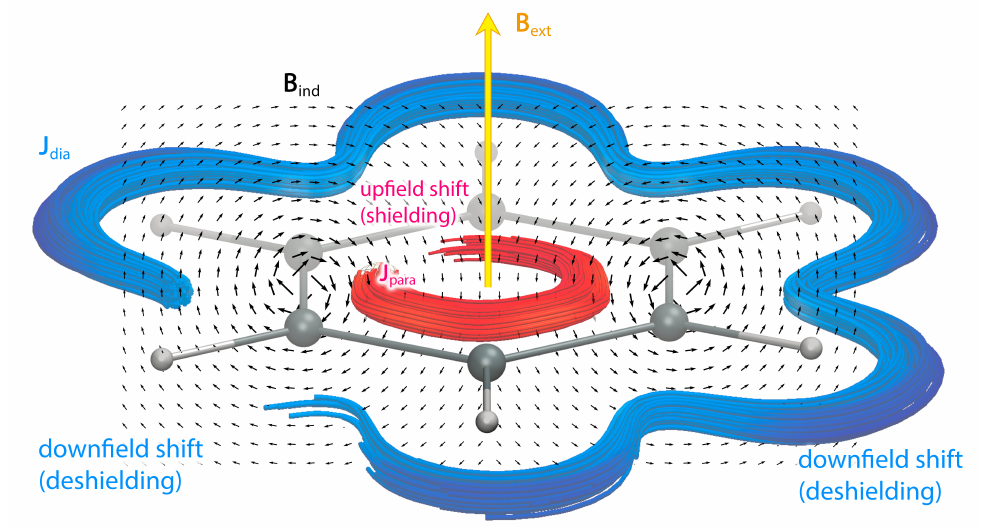
Figure 1. Illustration of the induced magnetic field (black arrows) when the aromatic benzene is exposed to an external magnetic field (yellow) perpendicular to the molecular ring. The magnetically induced current density circling in the classical direction is called diatropic (blue) and the one flowing in the opposite direction is paratropic (red). The induced magnetic field in the center of the ring points in the opposite direction relative to the applied field, while it deshields the nuclear magnetic moment of the hydrogen atoms outside the